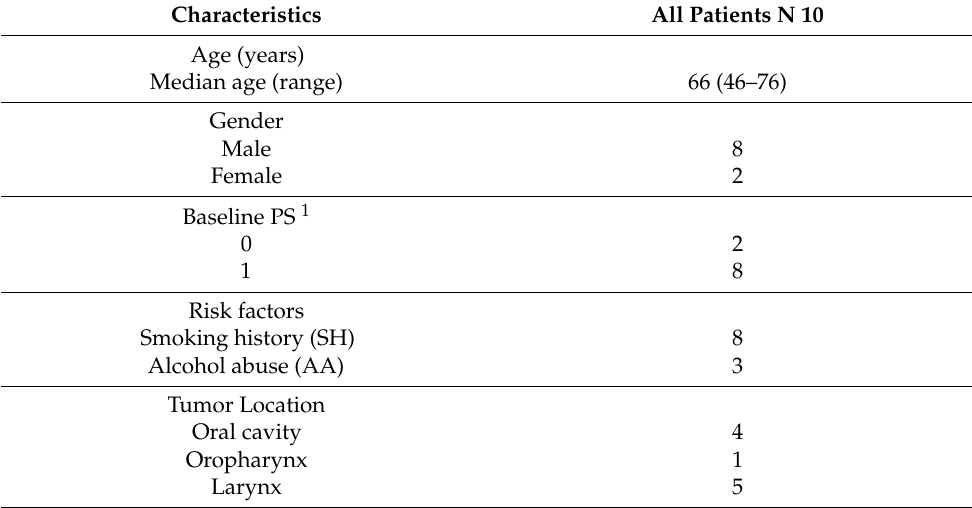
Table 1. Clinicopathological characteristics of platinum refractory HPV 2 negative R/M HNSCC and previous